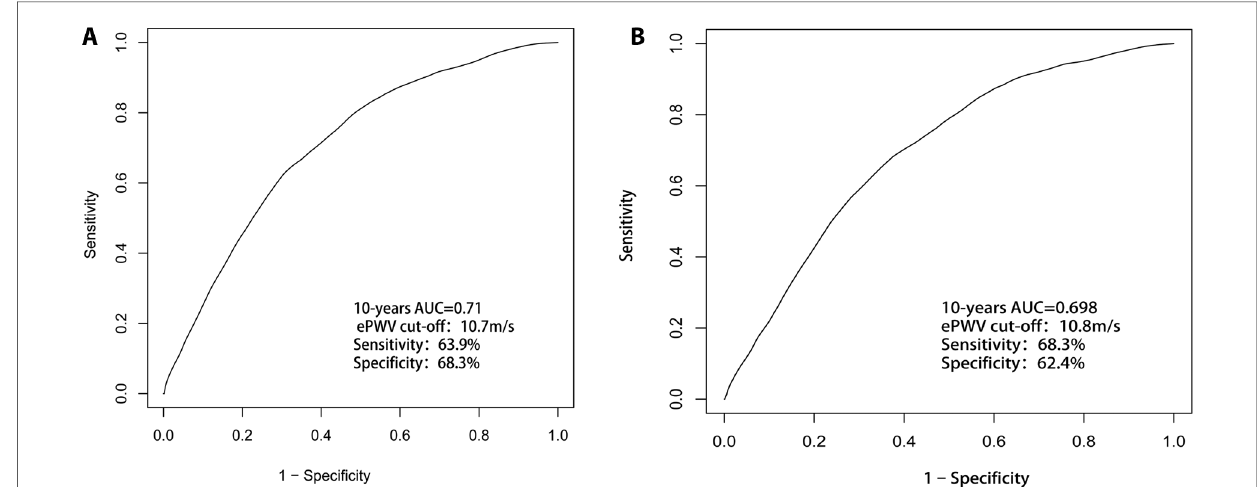
FIGURE 4 ( A ) ePWV had a strong predictive value (AUC=0.71) for 10-year all-cause mortality in the stroke population; ( B ) ePWV maintained a strong predictive value (AUC=0.698) for 10-year CCD mortality in the stroke